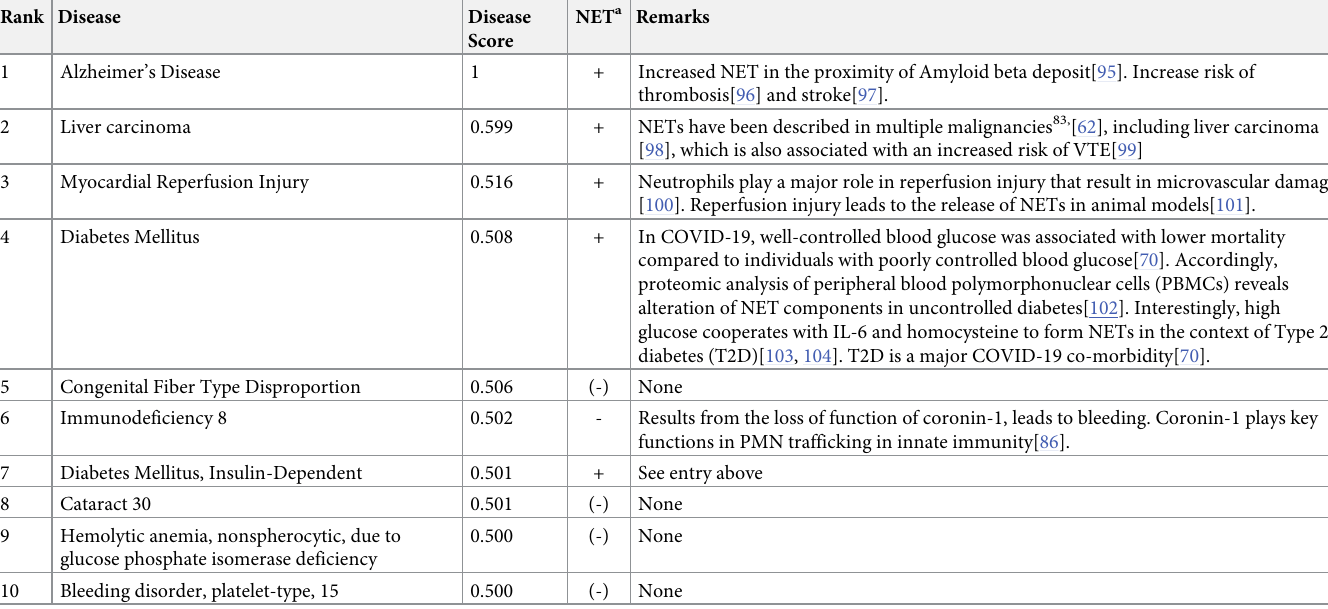
Abbreviations used: NETs = Neutrophil Extracellular Traps. a A “+” sign indicates demonstrated NET release in the disease, a “-” sign a deficiency in NETs. Brackets “()” around the “+” or “-” signs indicate prediction without published